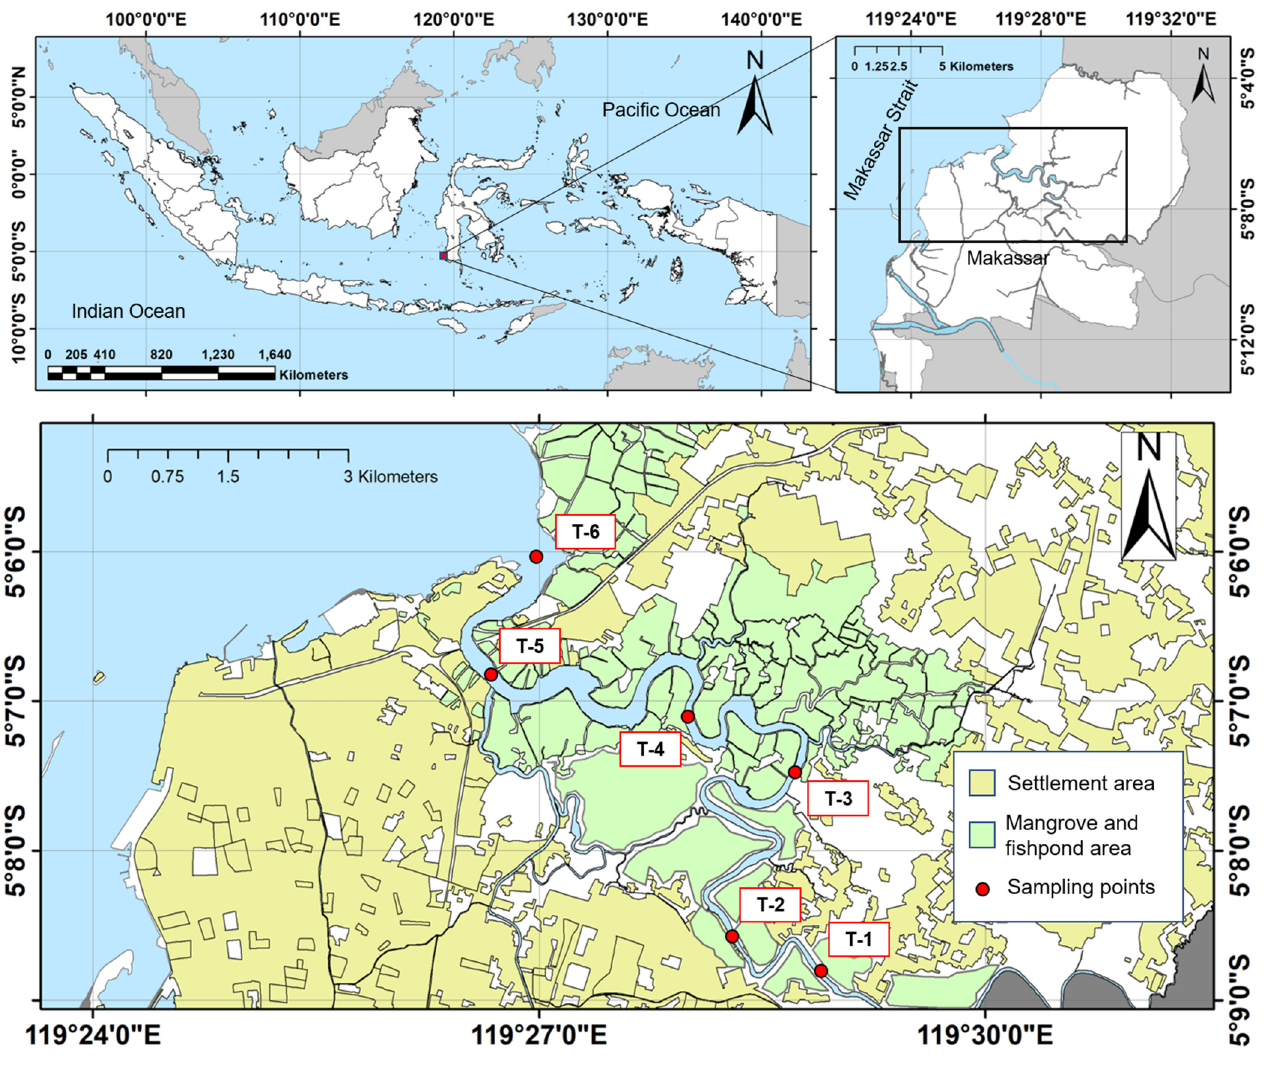
Figure 1. Sampling points on Tallo River.